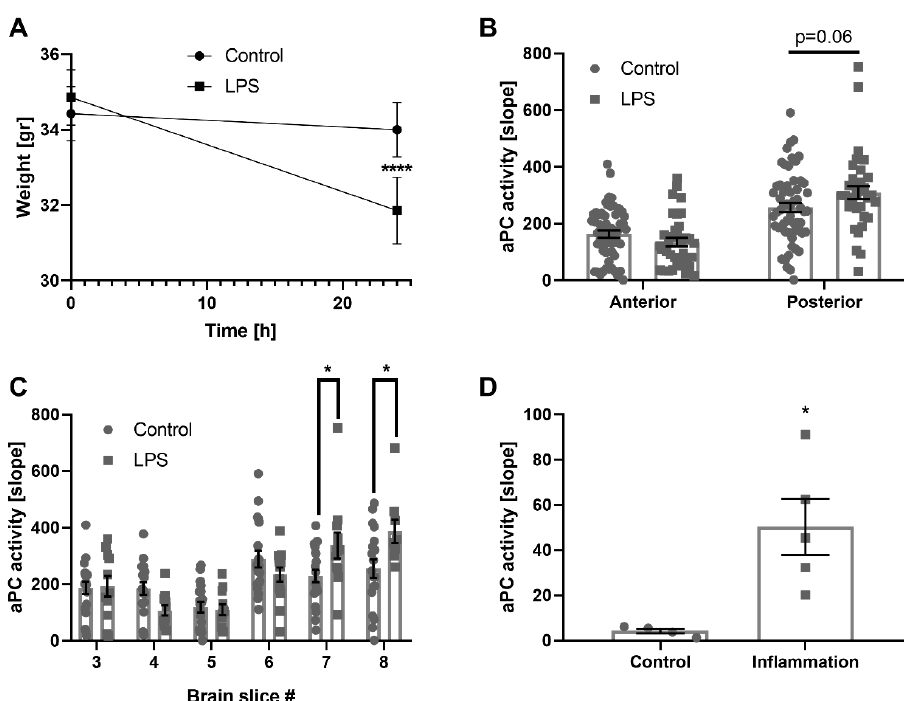
Figure 4. APC activity in a mice model for systemic inflammation and in human patients. ( A ) weight decline in LPS injected mice: LPS injected mice demonstrated a significant loss of weight 24 h following the injection, as a marker for the systemic inflammatory response ( n = 7, p < 0.0001). ( B ) APC activity in anterior versus posterior brain slices of LPS injected mice: Posterior brain slices of systemically injected mice showed a trend towards elevated APC activity compared to posterior brain slices of control mice ( n = 35 and 58, respectively, p = 0.06). ( C ) APC activity in brain slices of LPS injected mice: APC activity measurements conducted in brain slices showed significantly elevated activity in slices #7 and #8 of LPS injected mice compared to control ( n = 9 – 20, p = 0.04 and p = 0.017, respectively). ( D ) elevation of APC activity in human cerebrospinal fluid (CSF) of patients suffering from systemic inflammation: CSF samples taken from patients with systemic inflammation showed significantly elevated APC activity compare to healthy controls ( n = 5 and 4, respectively, p = 0.01).